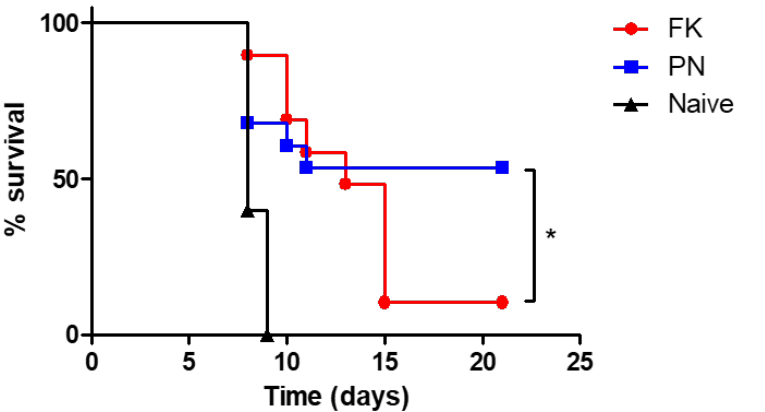
Figure 5. Survival of mice immunized by whole bacterial antigens inactivated by formalin (n = 14) or peroxynitrite (n = 14). Balb/c mice were immunized intranasal with 10 8 cfu/mL of formalin (FK)- or peroxynitrite (PN)-inactivated bacteria. Fourteen days post-immunization, mice were challenged intranasal with 10 LD 50 (10 4 cfu/mL) of F. tularensis LVS. Survival was monitored for 21 days. Naïve mice (n = 10) were used as controls. (*) p < 0.05.